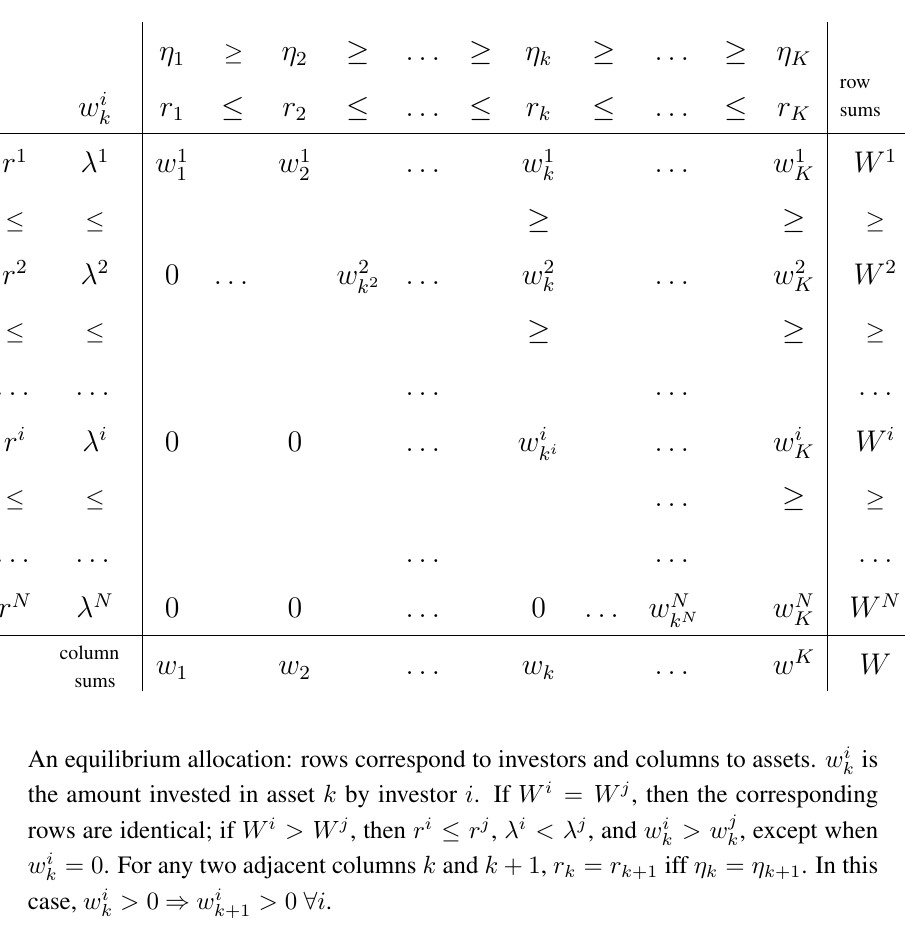
Table 1. The structure of